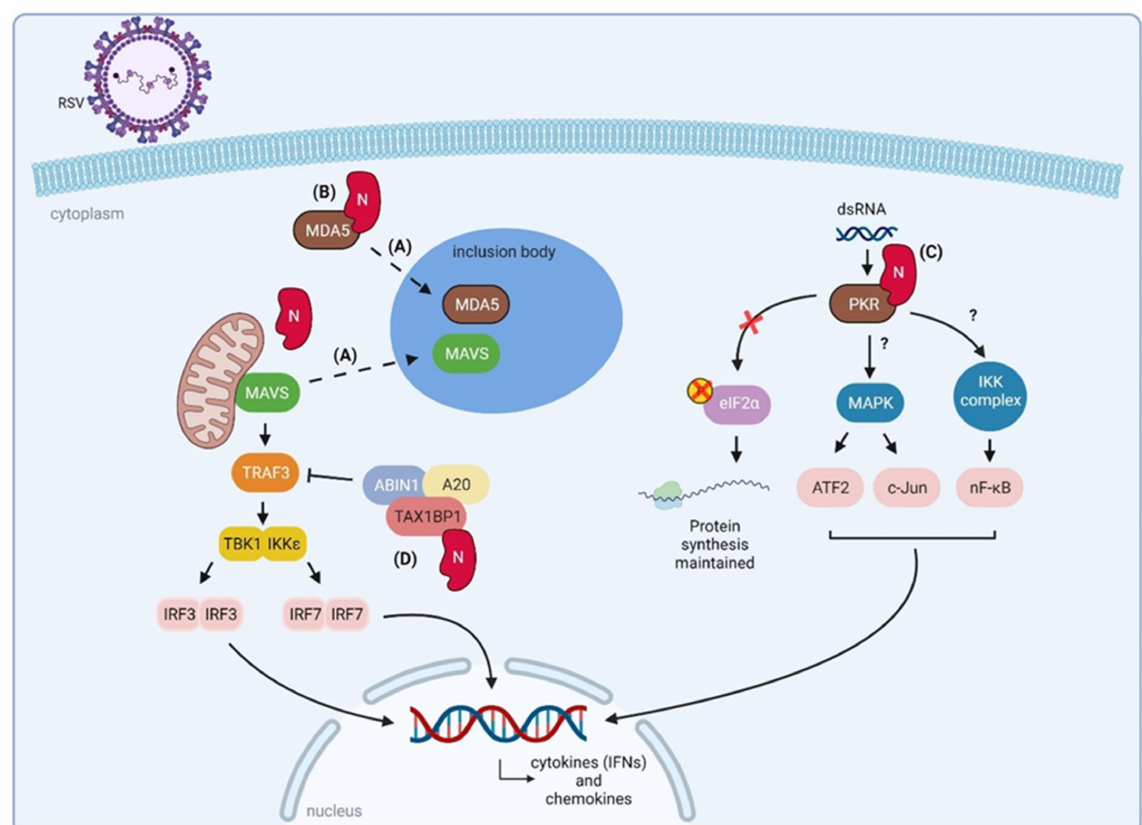
Figure 5. Proposed roles of RSV N in suppression of host innate immune responses. ( A ) RSV N sequesters MAVS and MDA5 to IBs. ( B ) RSV N directly interacts with MDA5. ( C ) RSV infection results in activation of PKR, which is involved in several signaling pathways. The binding of RSV N to PKR prevents phosphorylation of eIF2 α by PKR and consequently to the conservation of mRNA translation. The biological effect of the RSV N-PKR interaction on downstream MAPK and IKK signaling remains elusive. ( D ) RSV N interacts with TAX1BP1, which is part of a multiprotein complex (together with ABIN1 and A20) that negatively regulates the host innate immune response by disrupting the interaction between TRAF3 and TBK1/IKK ε . ABIN1, A20-binding inhibitor of NF- κ B1; ATF2, activating transcription factor 2; eIF2 α , α subunit of eukaryotic translation initiation factor 2; IBs, inclusion bodies; IKK, inhibitor of nuclear factor kappa-B kinase; IRF3, interferon regulatory factor 3; IRF7, interferon regulatory factor 7; MAVS, mitochondrial antiviral-signaling protein; MDA5, melanoma differentiation-associated protein 5; TBK1, tank binding kinase 1; TAX1BP1, Tax1-binding protein 1. Figure created with BioRender software (BioRender.com (accessed on 13 January 2022)). TAX1BP1 acts as a cofactor of the ubiquitin-editing enzyme A20, which is